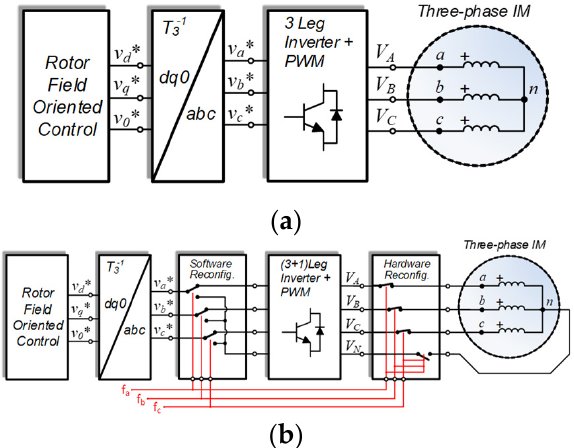
Figure 2. Three-phase induction motor drive with RFOC controller: ( a ) Typical topology for healthy operation, ( b ) Reconfigurable fault-tolerant topology with fault emulation signals f n (n: a, b, c).